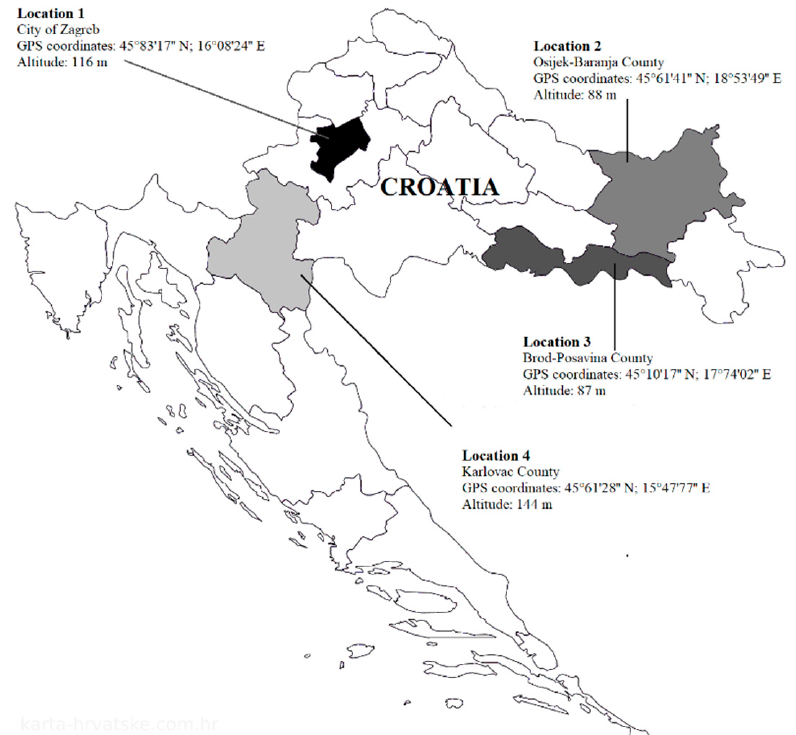
Figure 1. Sampling sites (Location 1, Location 2, Location 3 and Location 4) where few types of artificial nests of Osmia spp. bees were collected, from different environments in the continental part of Croatia.